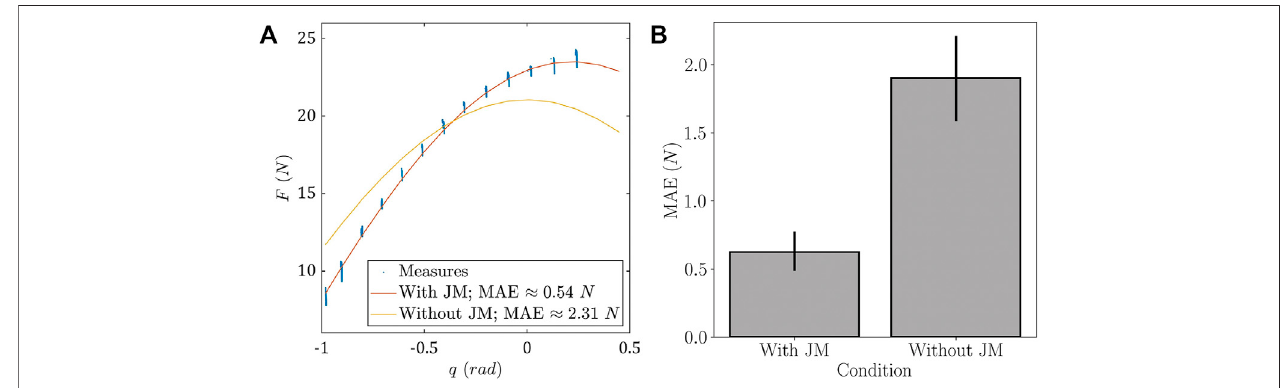
FIGURE6| EffectsofJMonmodelbehaviorandMAEs. (A) Exampleofdifferencesinmodelidenti fi cationforarepresentativeparticipant. (B) Boxplotsrepresenting MAEs repartition with and without